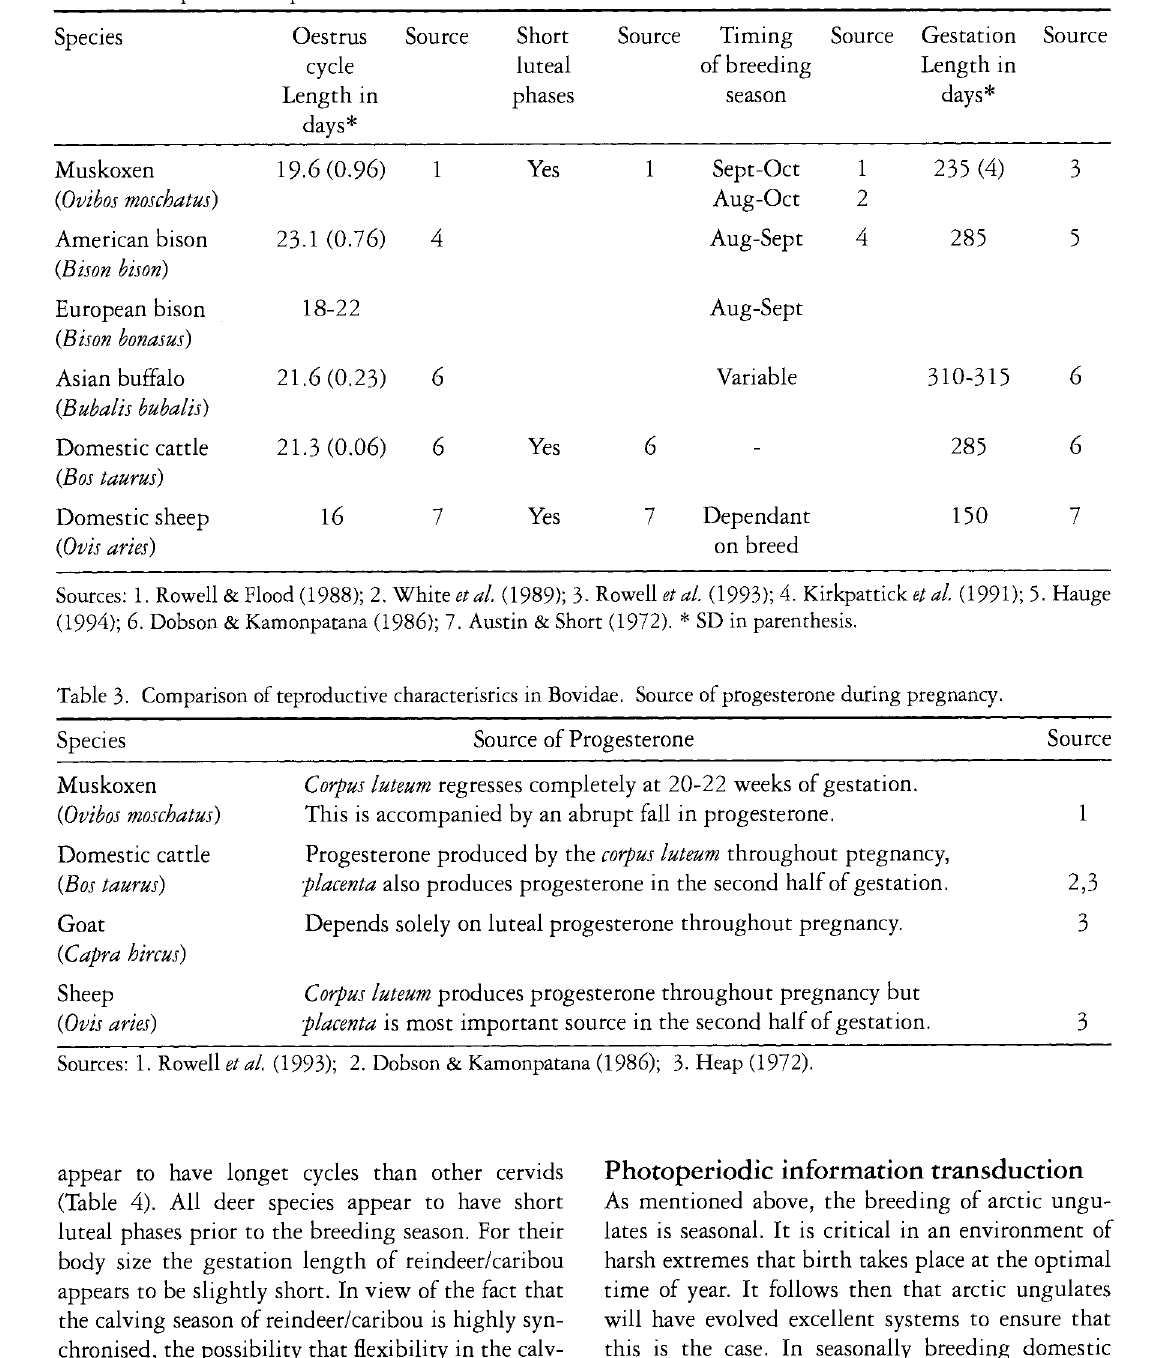
Table 2. Comparison of reproductive characteristics in Bovidae.